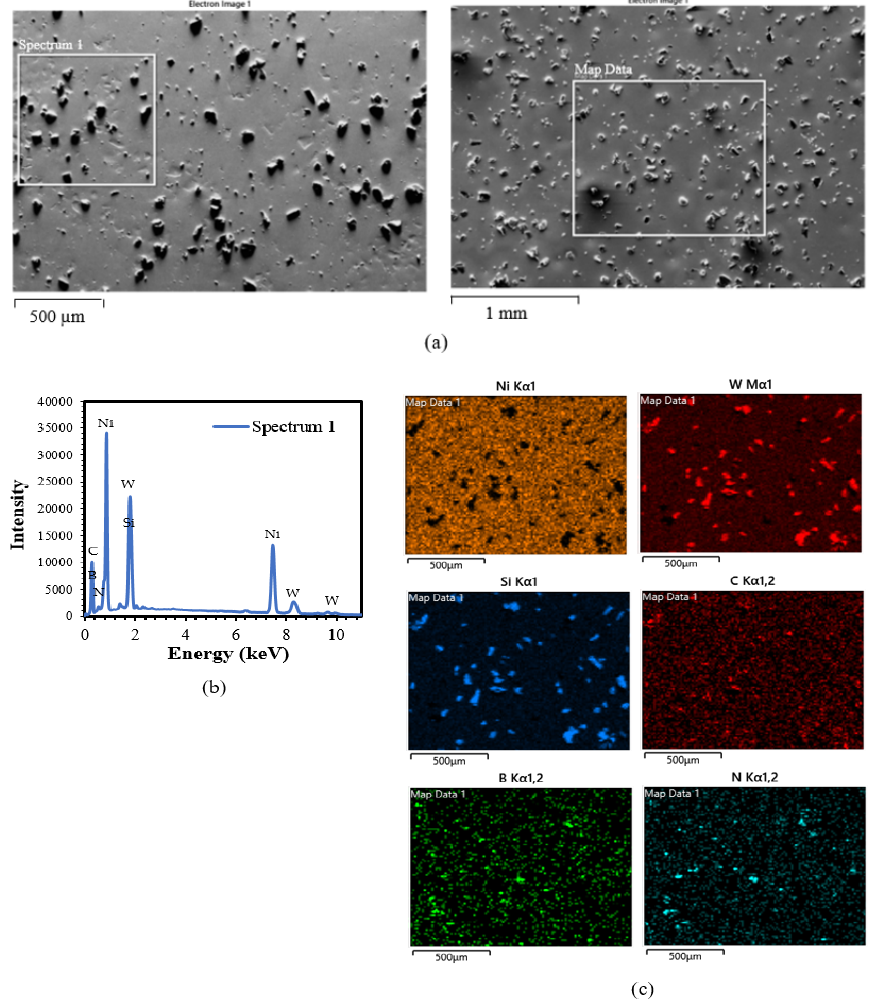
8 of 20 Figure 6. SEM micrograph ( a ), EDS spectra ( b ), and X-ray mapping ( c ) taken from the surface of the NiW–hBN coating; EDS map ofthe area is highlighted with a white rectangle in the SEM image.